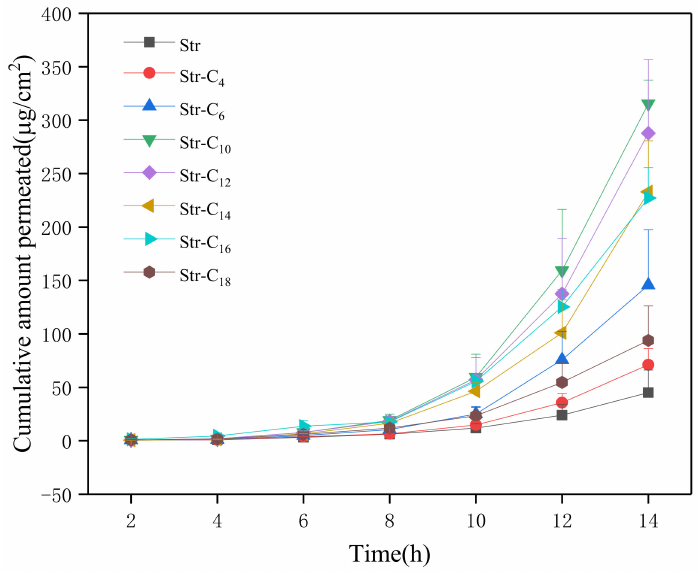
Figure 4. In vitro permeation profiles of Str and Str ion-pair complexes ( n = 3).